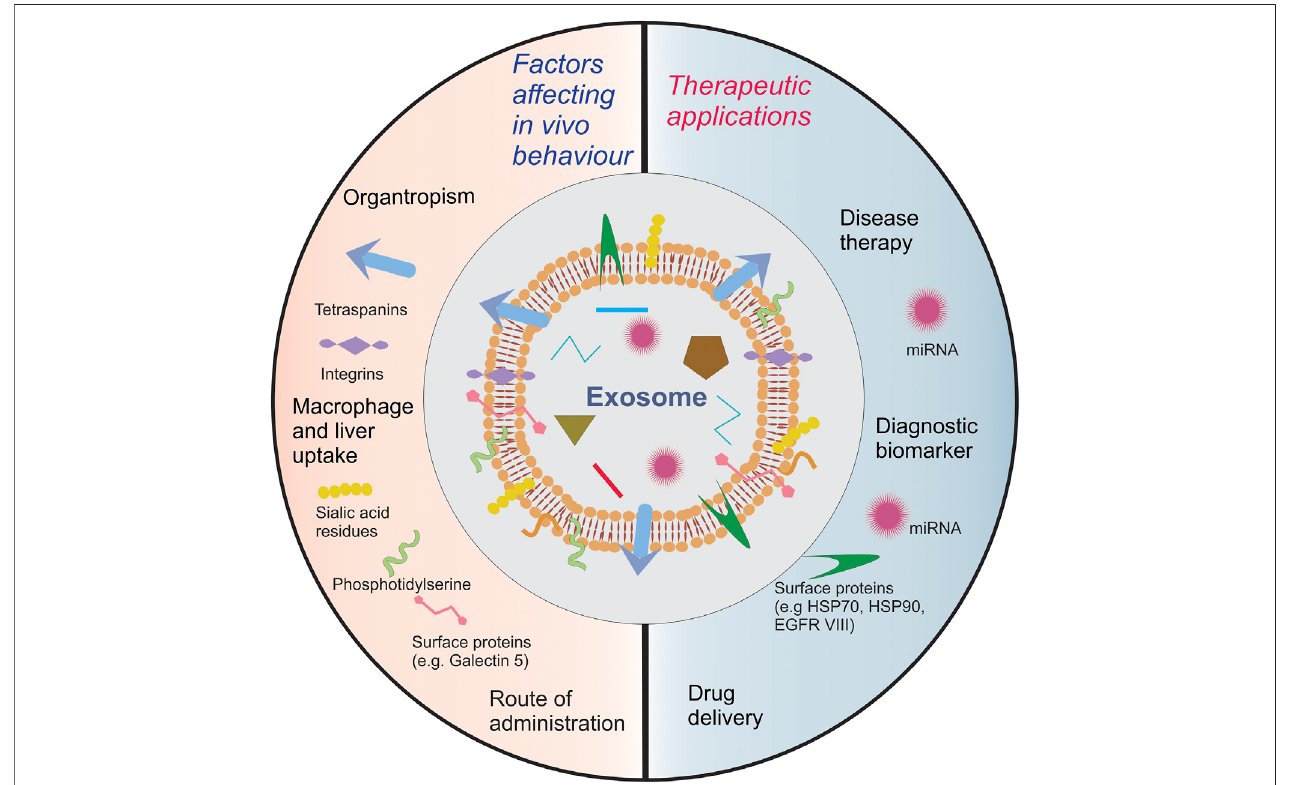
FIGURE 2 | A summary of exosome biomolecules affecting exosome pharmacokinetics and their role in therapy.